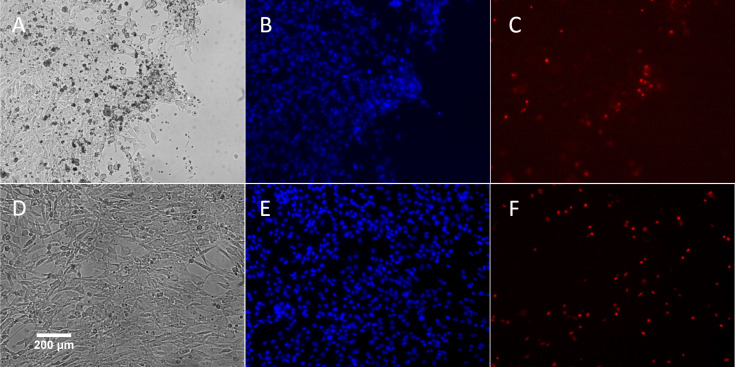
A representative live cell image of porcine fibroblast cells after exposure to 380 nA of electrical biostimulation.(A-C): Same cells in Chamber I; (D-E): Same cells in Chamber III. (A) and (D): Cells visualized with transmitted light. (B) and (E): Blue fluorescence represents Hoechst 33342 nuclear staining. (C) and (F): Red fluorescence represents staining with propidium iodide.